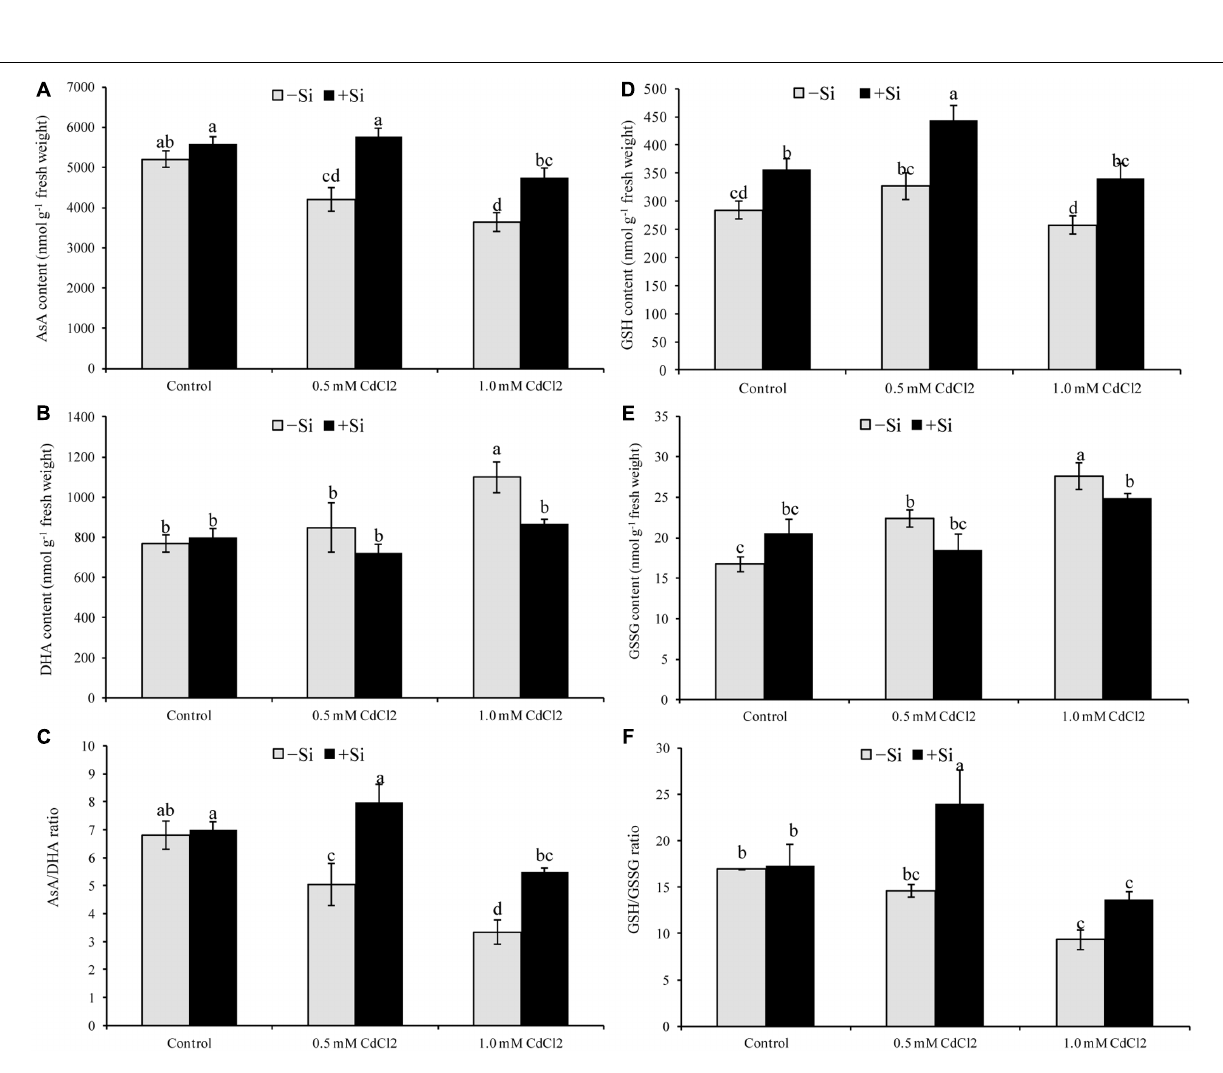
FIGURE 3 | Silicon-induced changes in ascorbate (AsA) (A) , glutathione (GSH) (D) , DHA (B) , GSSG (E) and their redox pool (C,F) in Brassica napus seedlings grown under Cd stress. Values (Mean ± SD) of each treatment are obtained from three replications. Bars with different letters are significantly different at P < 0.05 applying Tukey’s HSD